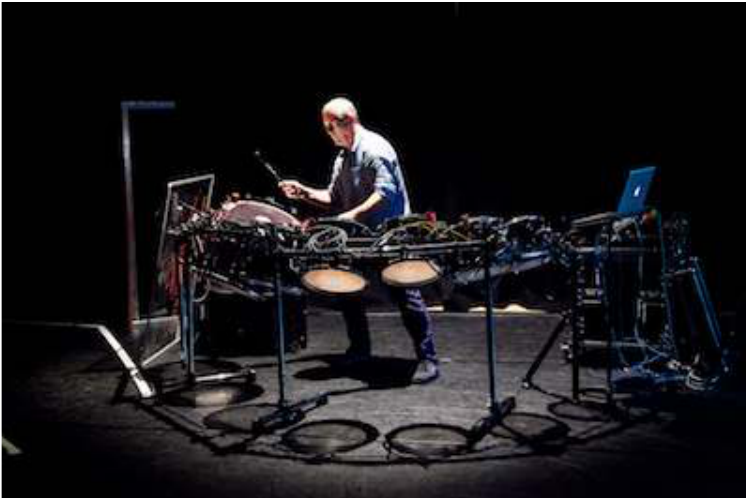
Figure 3: Still from a performance of Doe Den Tap Toe